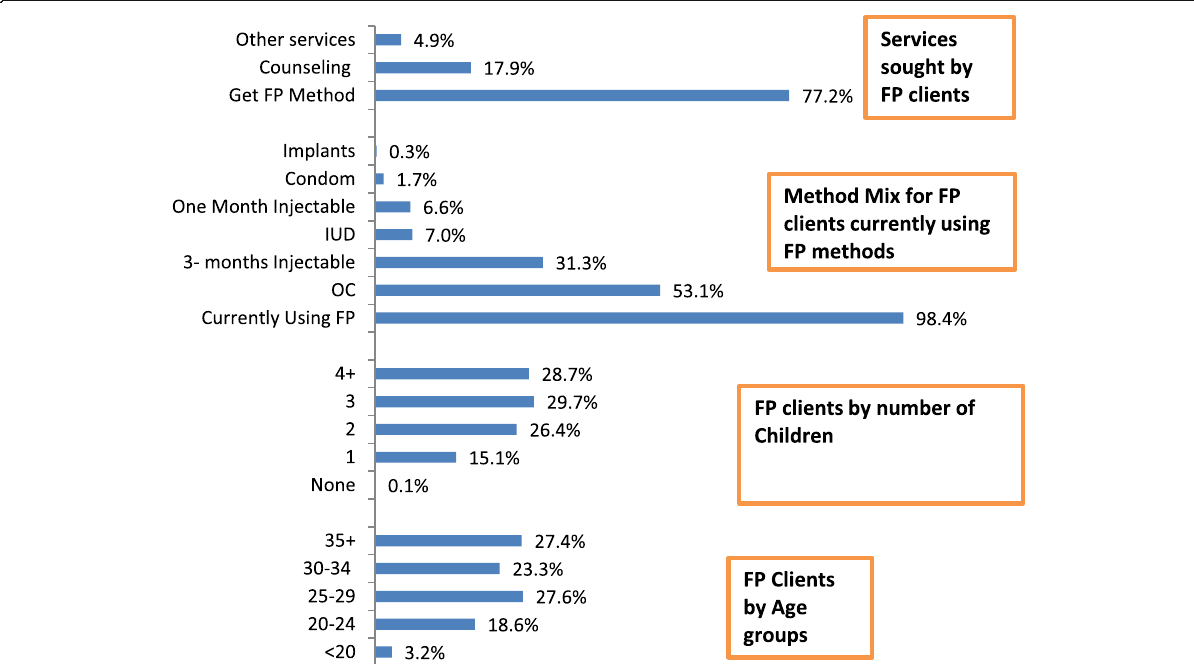
Fig. 1 Profile of MOHP- FP clinics ’ clients (age and number of children), who were currently using contraceptive method, reasons of visits to FP clinics in 2014 (total clients =